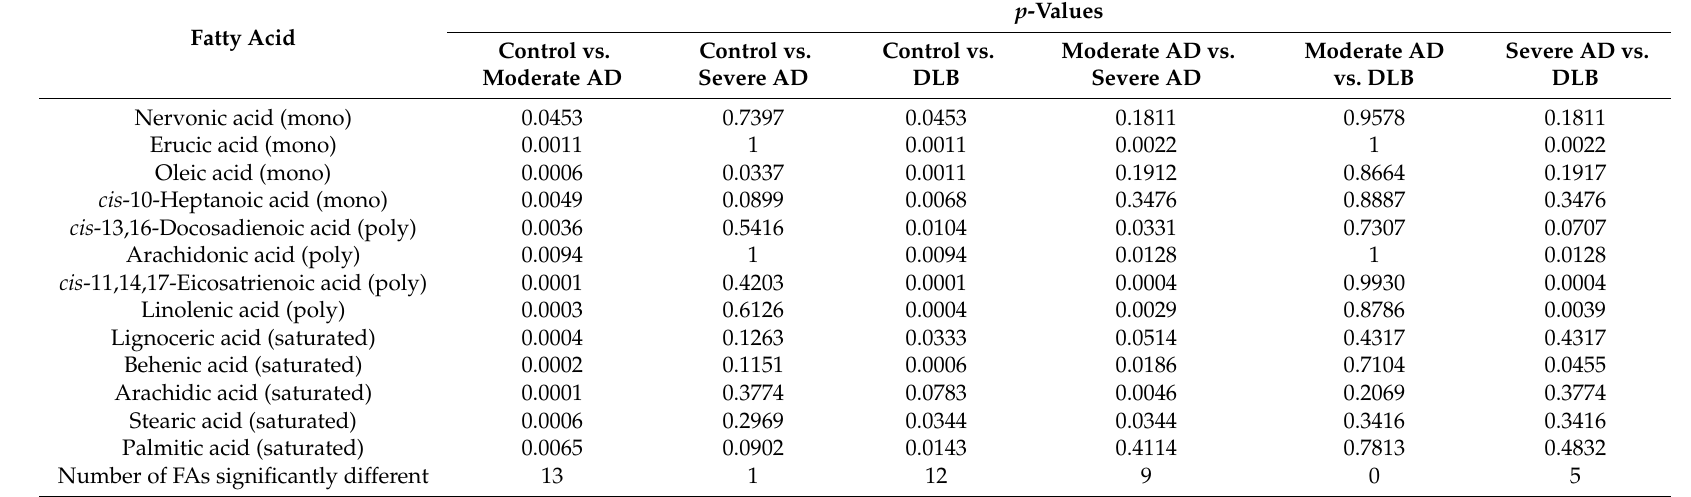
Table 2. Fatty acids significantly higher in post-mortem brain tissue from subjects with moderate AD, severe AD, or DLB pathology. Following the Kruskal–Wallis tests, multiple comparison procedures using stepdown permutation p -values on the ranked data were used to investigate the nature of group differences for variables with a false discovery rate of 0.05 or